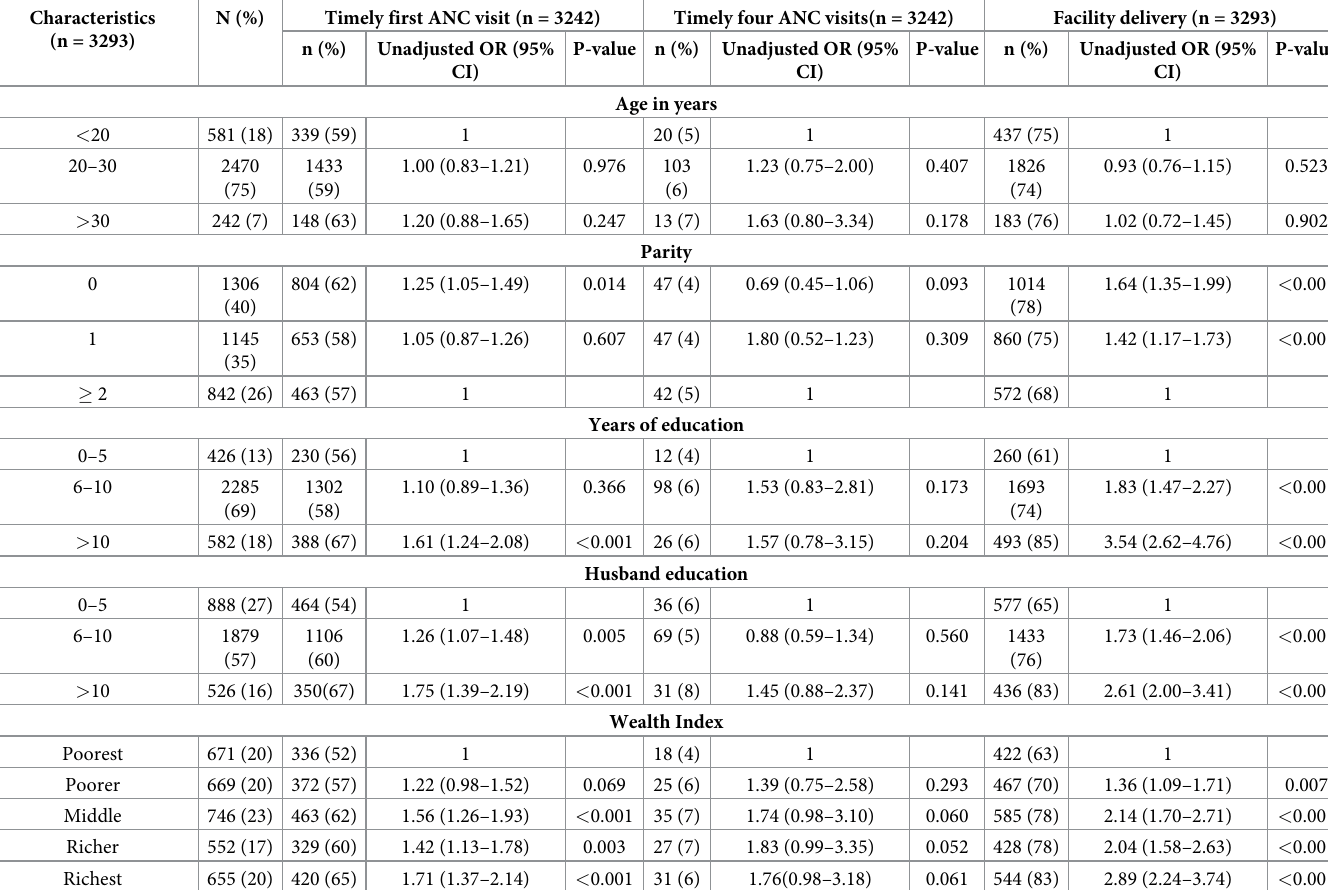
Table 1. Associations of timely first ANC visit, timely four ANC visits, and facility delivery with socio-demographic determinants: Unadjusted odds ratios from logistic regression analysis. Characteristics (n = 3293)